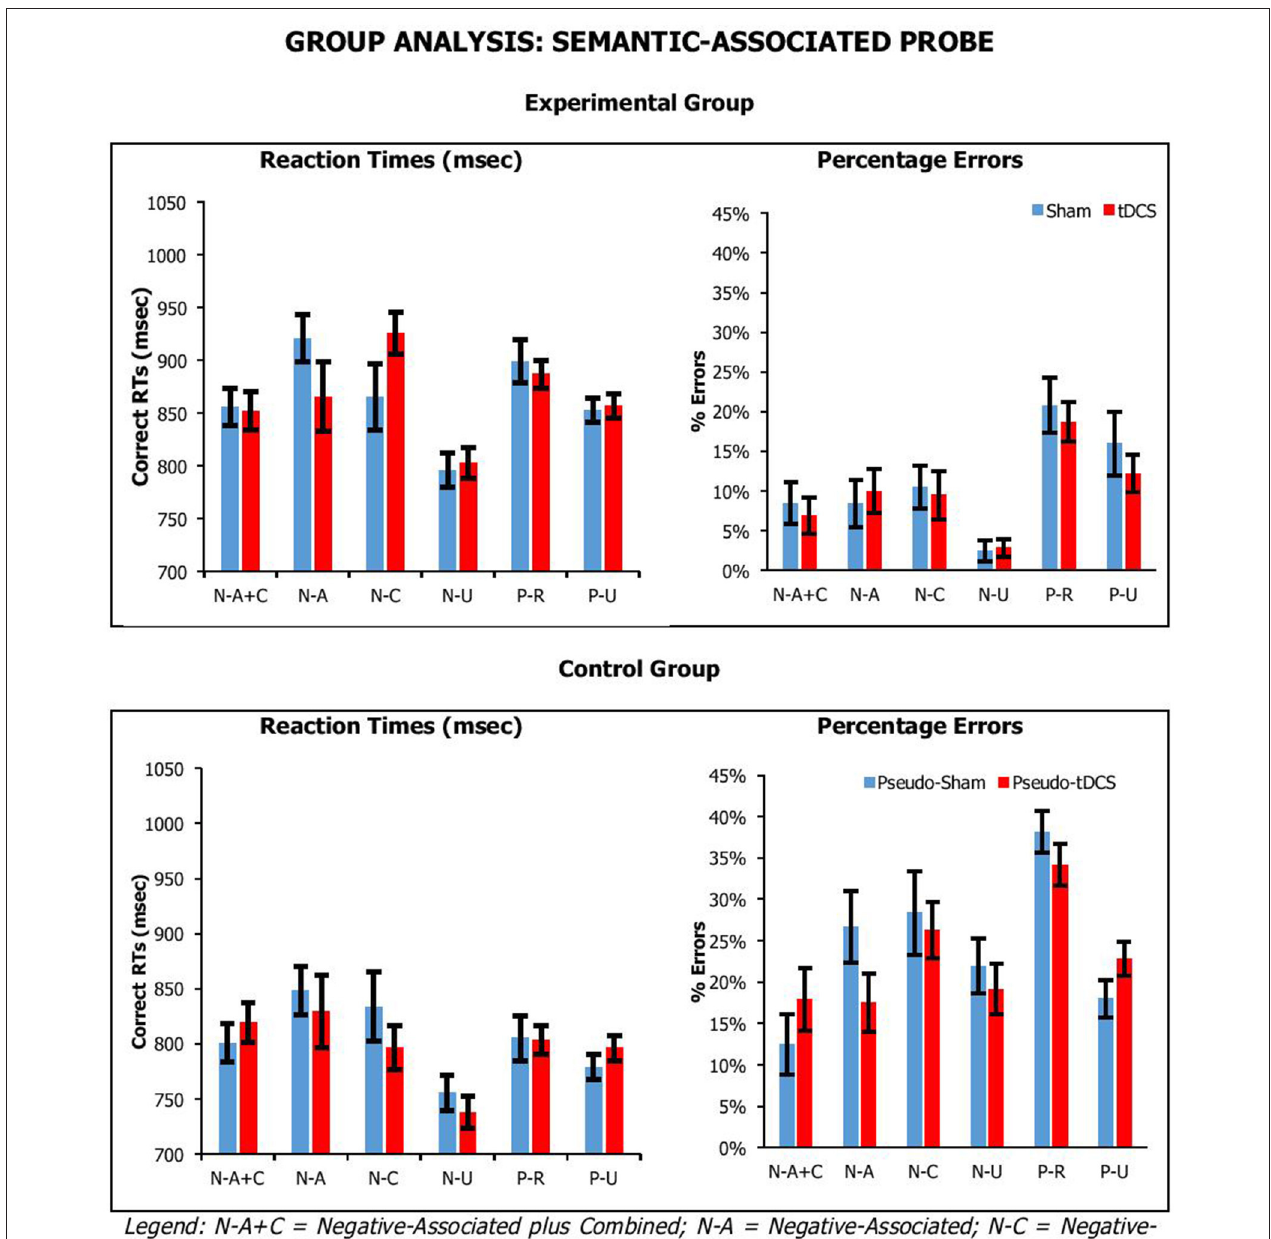
FIGURE 4 | Average correct RTs (ms) and percentages errors for semantic-associated probe across participant groups, probe conditions, and stimulation conditions. Error Bars indicate Standard Error.